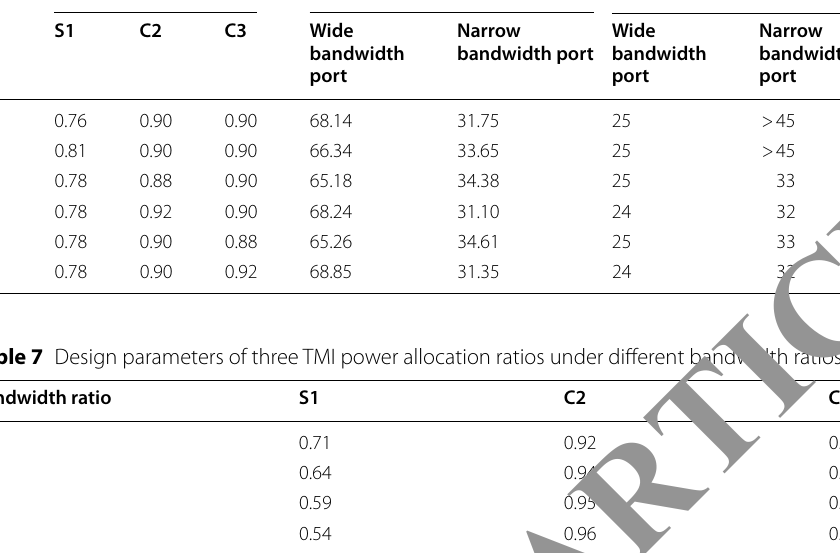
Table 6 Simulation results of different TMI splitting ratios Parameter Δ f (GHz) Isolation